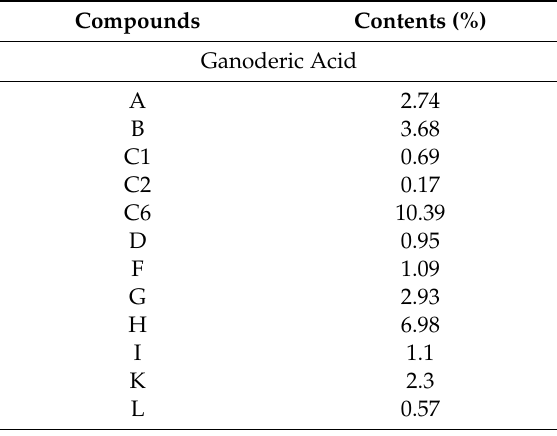
Table 1. The major bioactive substances in G. lucidum